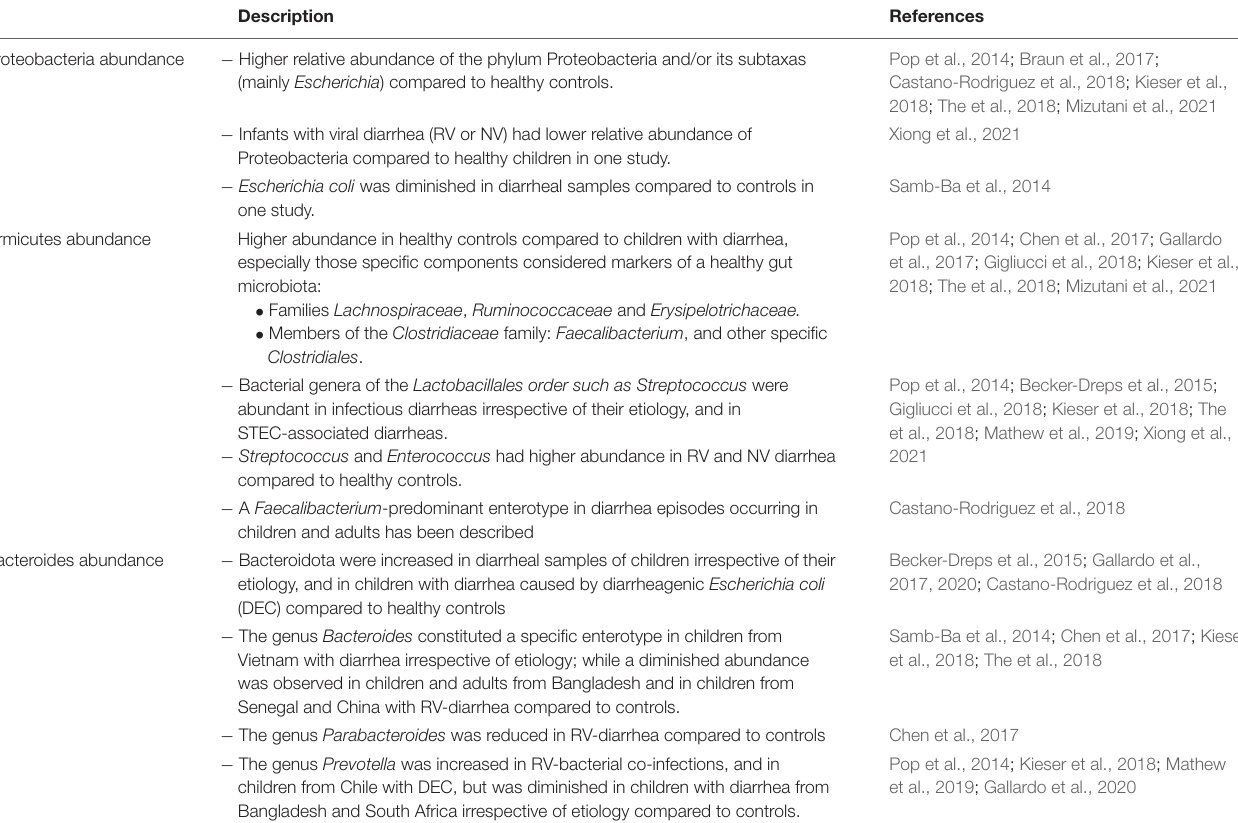
TABLE 4 | Abundance of the gut microbiota’s main phyla and their components during diarrhea episodes compared to healthy